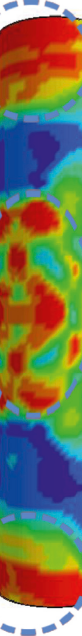
Figure 17: Vulnerable parts of the steel tube.